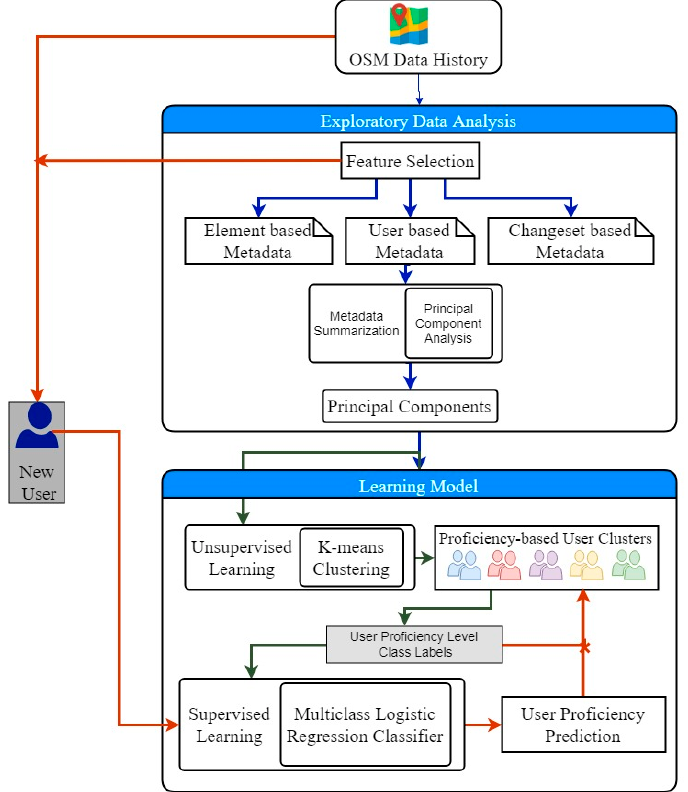
Figure 1. Overview of data-driven framework for user proficiency assessment model.